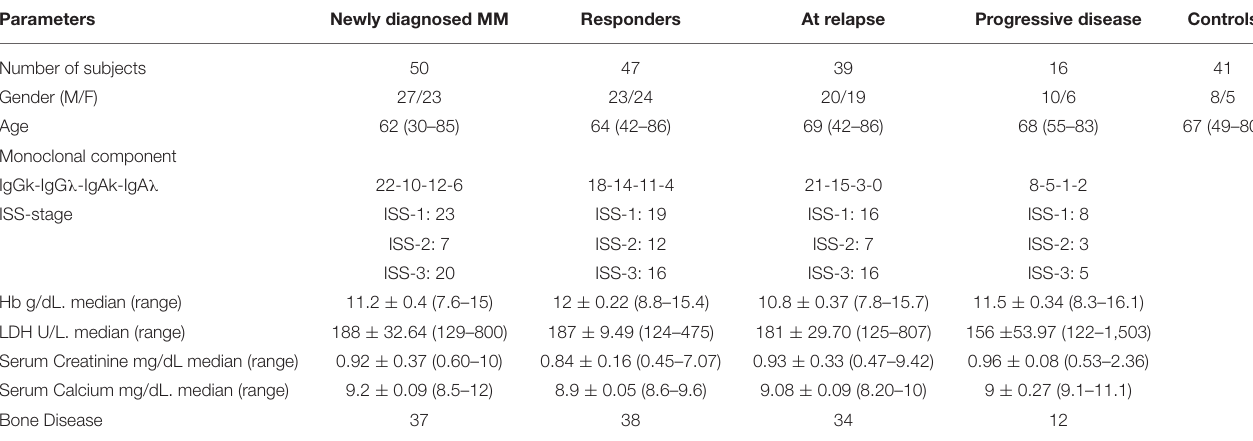
TABLE 1 | Characteristics of patients and controls.